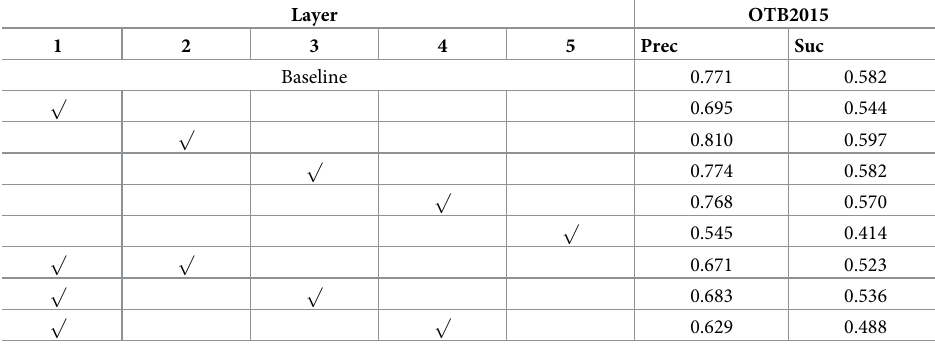
Table 1. Ablation study on different convolution layers. DOSiam achieves the best tracking performance when the DO-Conv is placed in the second